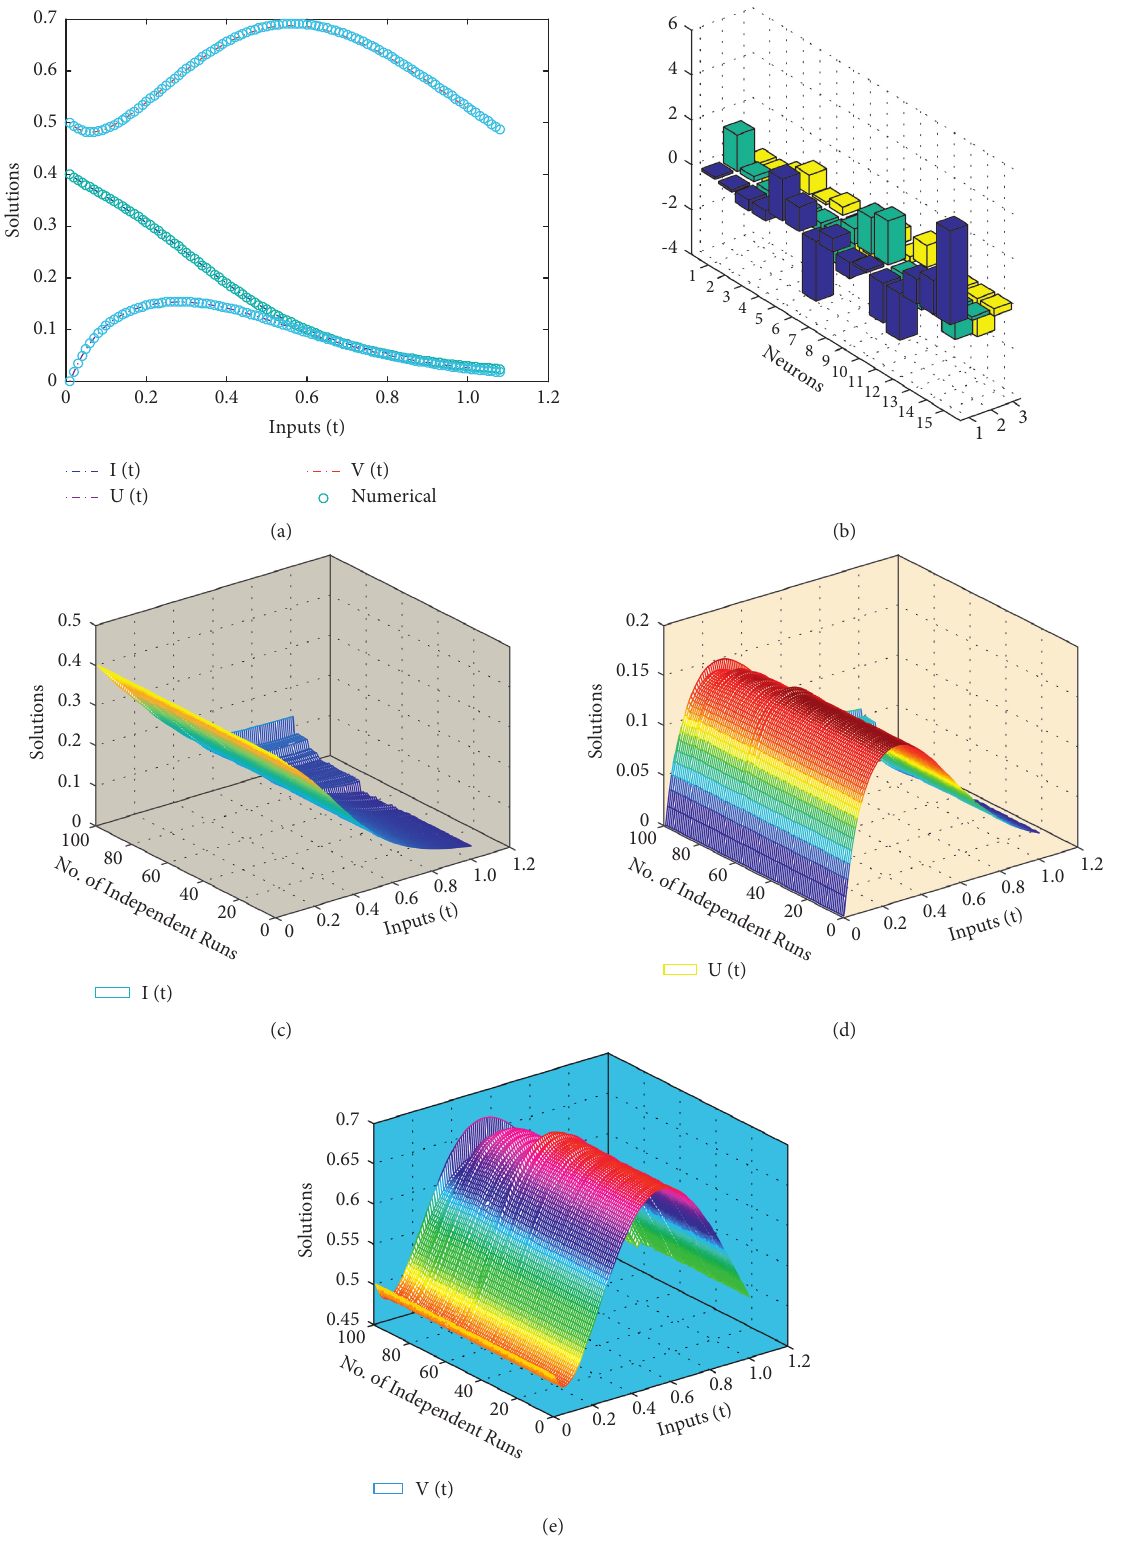
Figure 7: Problem 5: graphical evaluation for tumor growth ratio ( r ) to rate of cell lysis ( δ ) f � 0 . 36, the inverse of burst size parameter g � 0 . 02, and the viral decay ( α ) ratio to rate of cell lysis ( δ ) h � 0 . 15. (a) Solution f � 0.36, g � 0.02, and h � 0.15 with initial conditions I (0) � 0.4, U (0) � 0, and V (0) � 0.1, (b) weights obtained by ANN-SCA-SQP for CVRT, (c) solutions of 100 independent runs of I ( t ), (d) solutions of 100 independent runs of U ( t ), and (e) solutions of 100 independent runs of V ( t